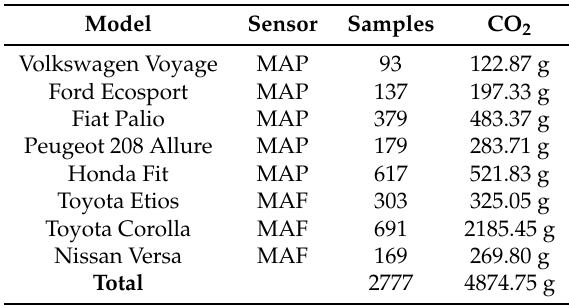
Table 6. Summary of data collected from all considered vehicles.